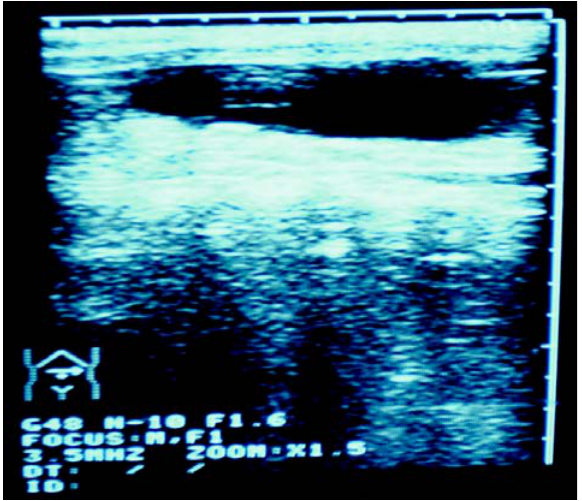
Figure 3 – Canine vesical stone, pre extracorporeal lithotripsy.